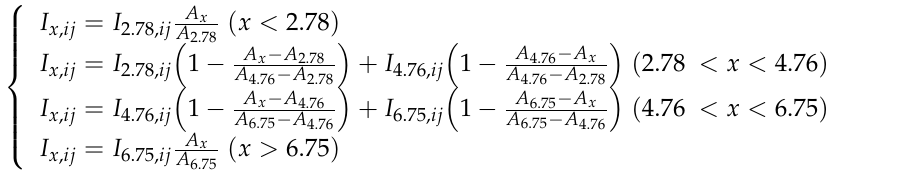
8 of 18 Table 3. Configurations and operating parameters of the simulated center pivot irrigation system. Configurations